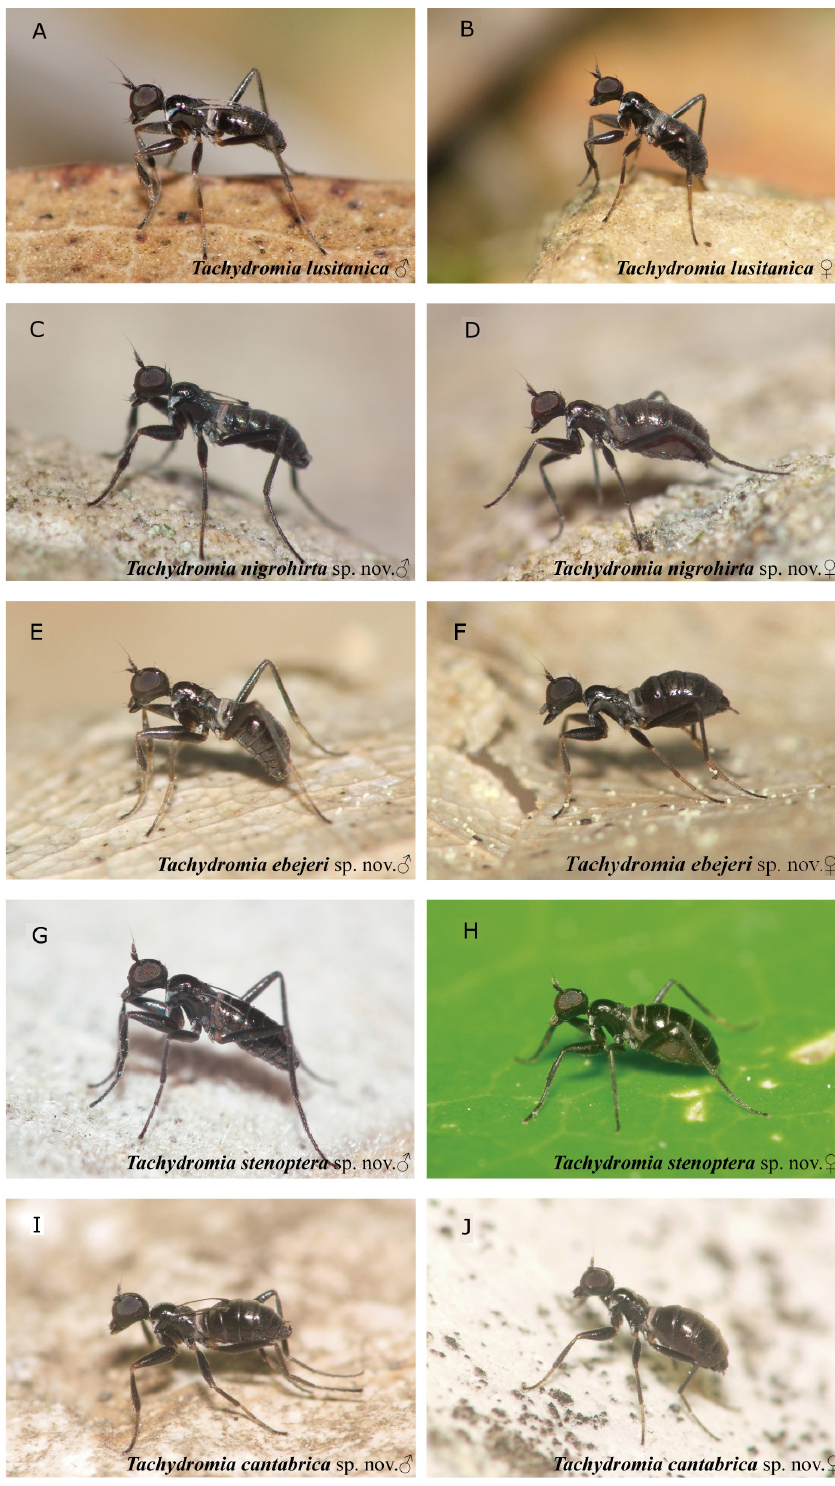
Fig. 15. Habitus of live specimens of the Iberian ant-like Tachydromia Meigen, 1803. Males are pictured in the left column, females in the right. A–B . T. lusitanica (Grootaert, Shamshev & Andrade, 2009). C–D . T. nigrohirta Gonçalves, Grootaert & Andrade sp. nov. E–F . T. ebejeri Gonçalves, Grootaert & Andrade sp. nov. G–H . T. stenoptera Gonçalves, Grootaert & Andrade sp. nov. I–J . T. cantabrica Gonçalves, Grootaert & Andrade